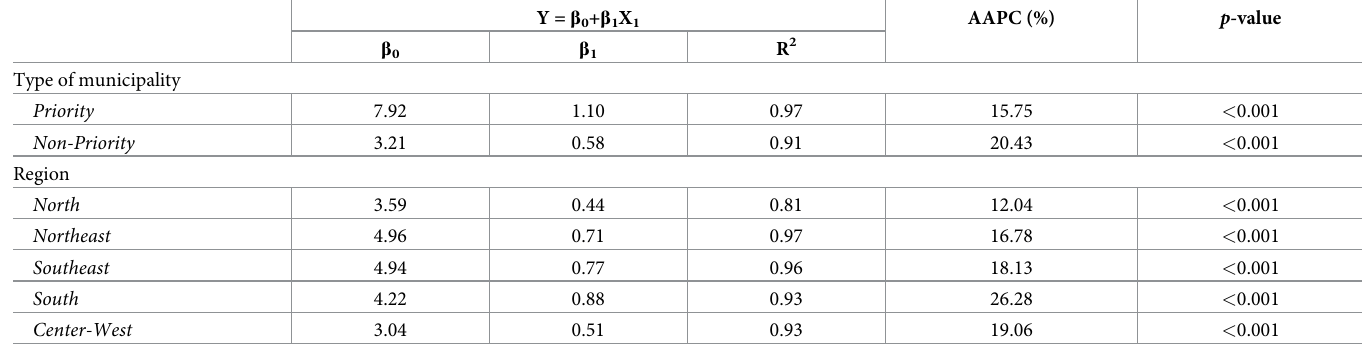
Table 3. Trend analysis of congenital syphilis rate in priority and non-priority municipalities and according to regions of Brazil, from 2007 to 2017. Database: National System of Aggravations and Notification—SINAN